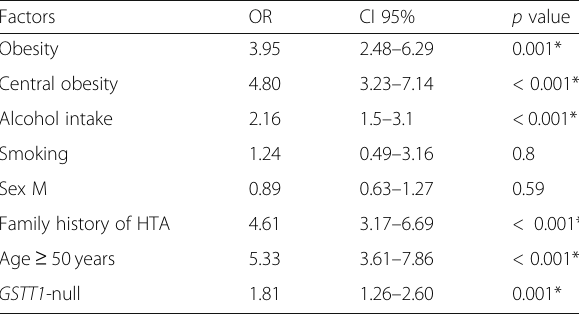
Table 3 Multinomial logistic regression for risk analysis of essential hypertension